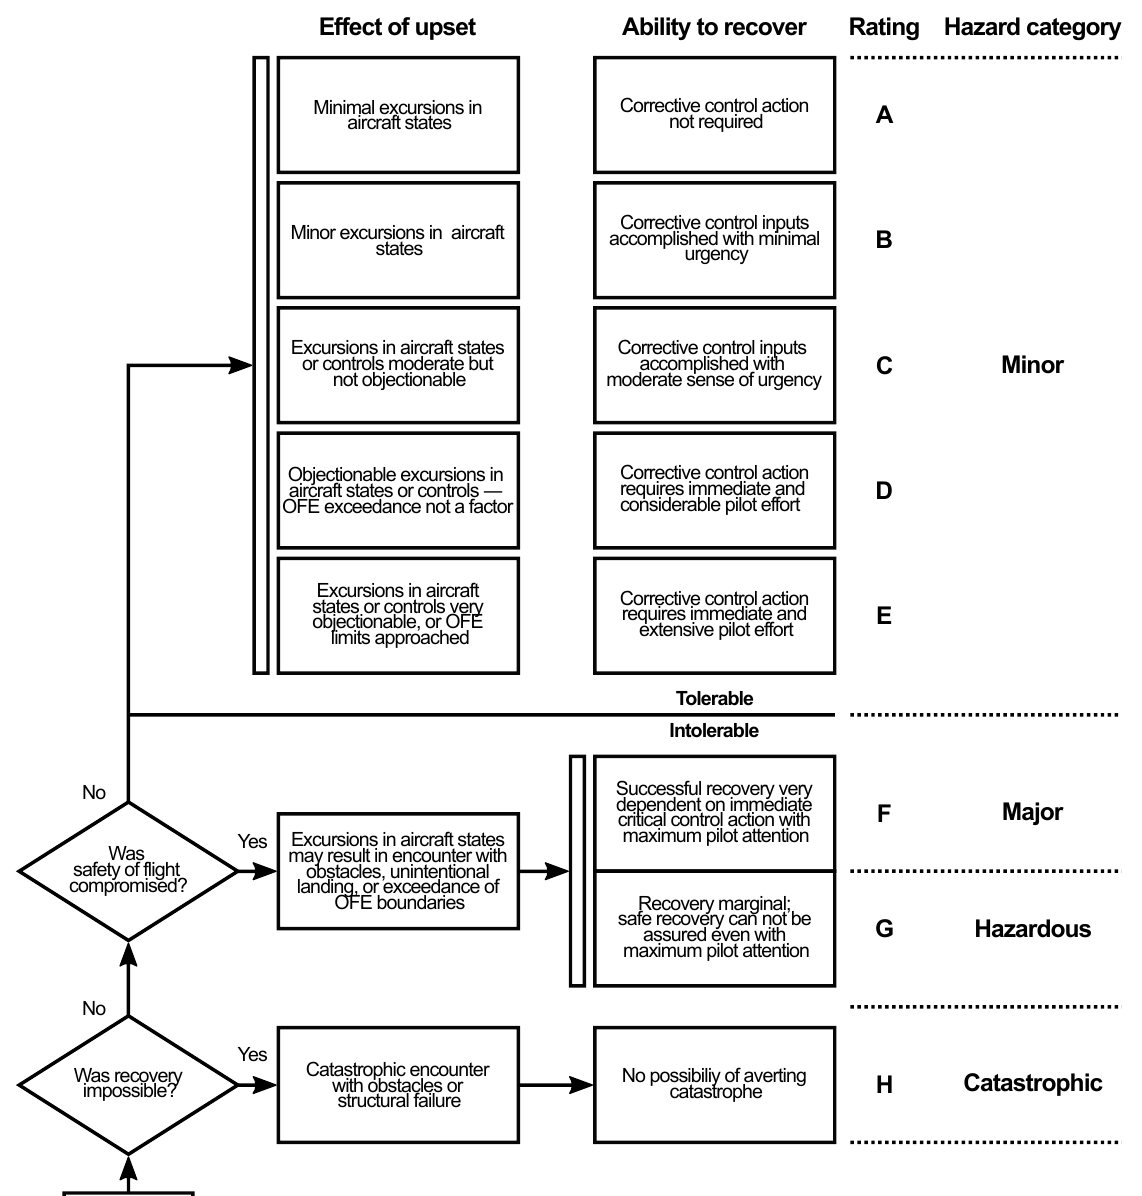
Figure A1. Upset Severity Rating (USR) with hazard categories minor ( A – E ), major ( F ), hazardous ( G ) and catastrophic ( H )